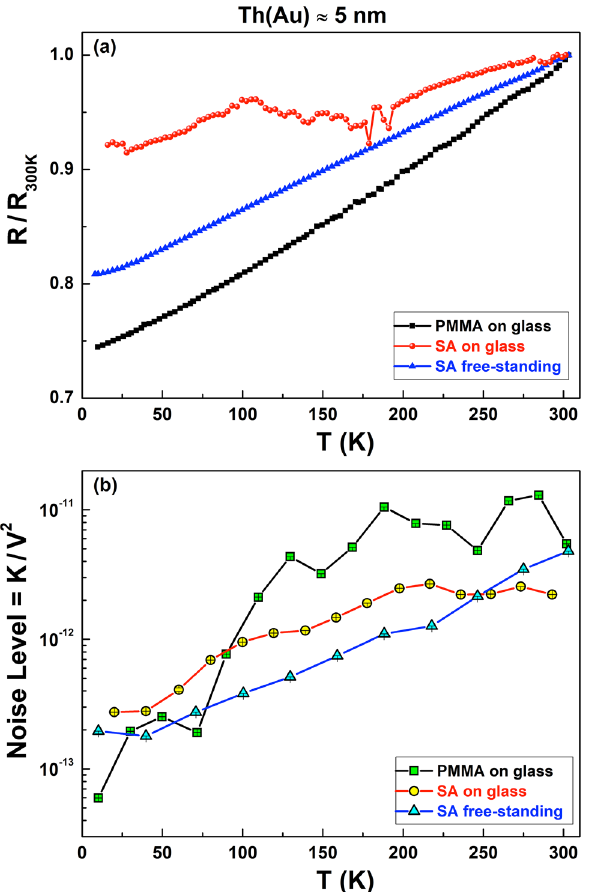
Figure 8. Comparison between DC and AC properties of metallic samples. The temperature dependencies of the normalized resistance R/R 300 K ( a ) and of the Noise Level NL ( b ) are shown for PMMA on glass (squares), SA on glass (circles), and SA free-standing (triangles) films. The typical characteristics of metallic compounds are observed, especially regarding the very low noise measured in the whole investigated temperature